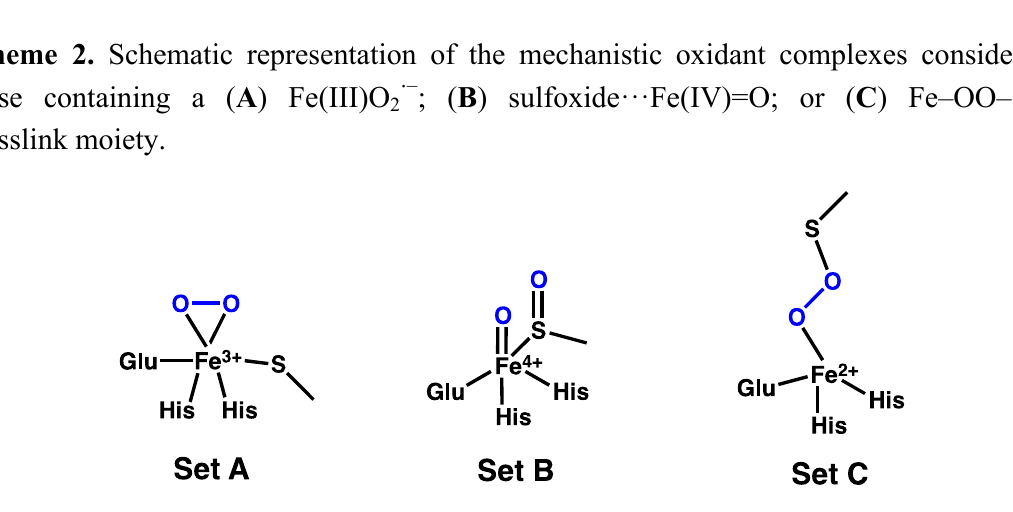
Scheme 2. Schematic representation of the mechanistic oxidant complexes